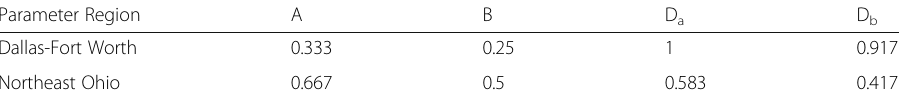
Table 2 Model parameter values for the DFW and NEO regions (A and B are dimensionless and D a and D b are expressed in units of the largest inter-locality distance: DFW: 9.735 ∗ 10 5 ft.; NEO: 5.647 ∗ 10 5